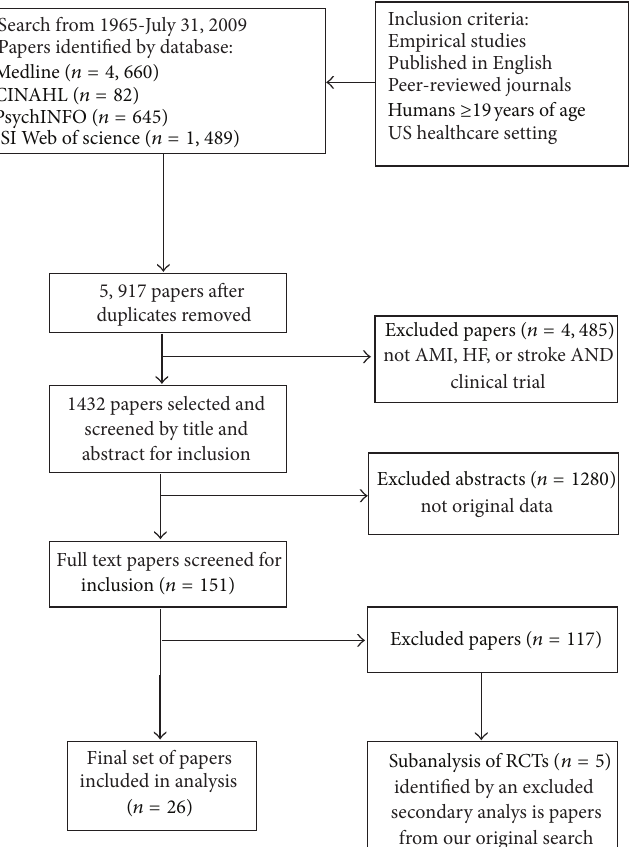
Figure 1: PRISMA